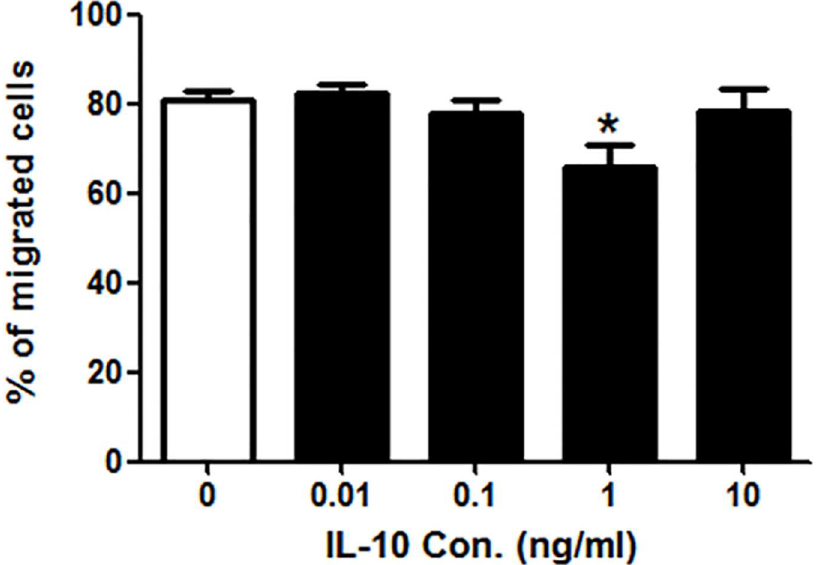
Fig 2. The effect of IL-10 on the transendothelial migration (TM) of mDCs. The migrationsof IL-10-treated mDCs were determined by Transwell assay. The migrated cells werecountedusinga haemmacytometer. Comparedwith controlgroup: * p <